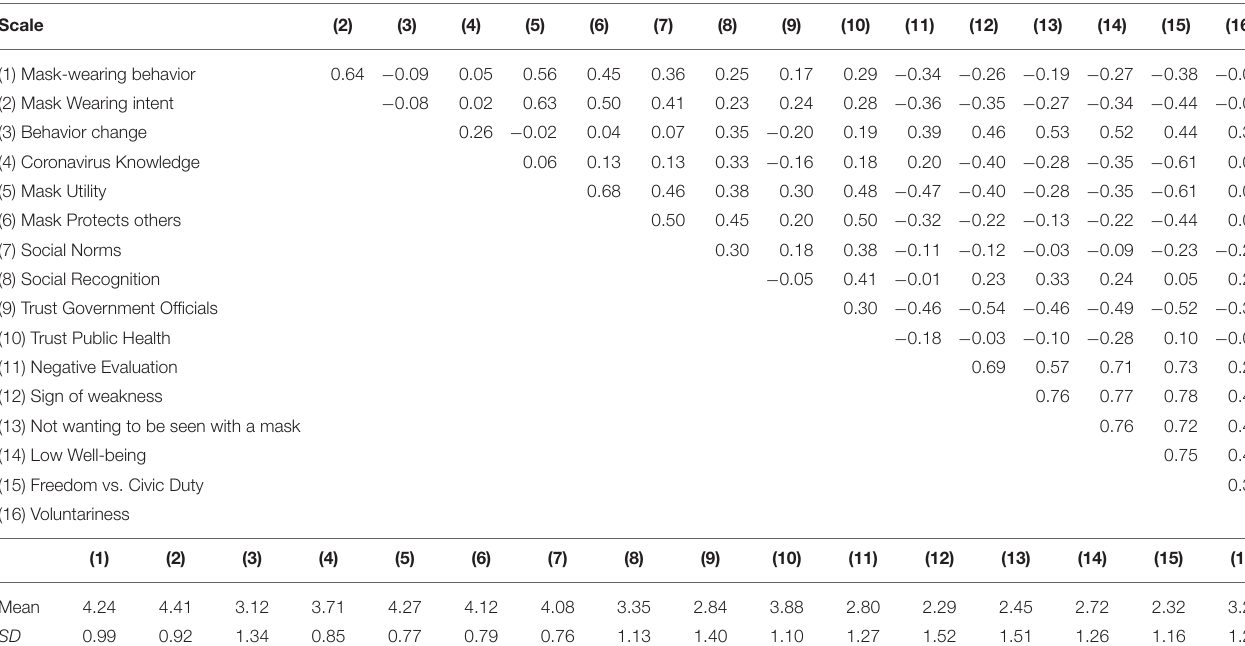
TABLE 1 | Correlation matrix and descriptive statistics for individual-level variables (dependent variables).